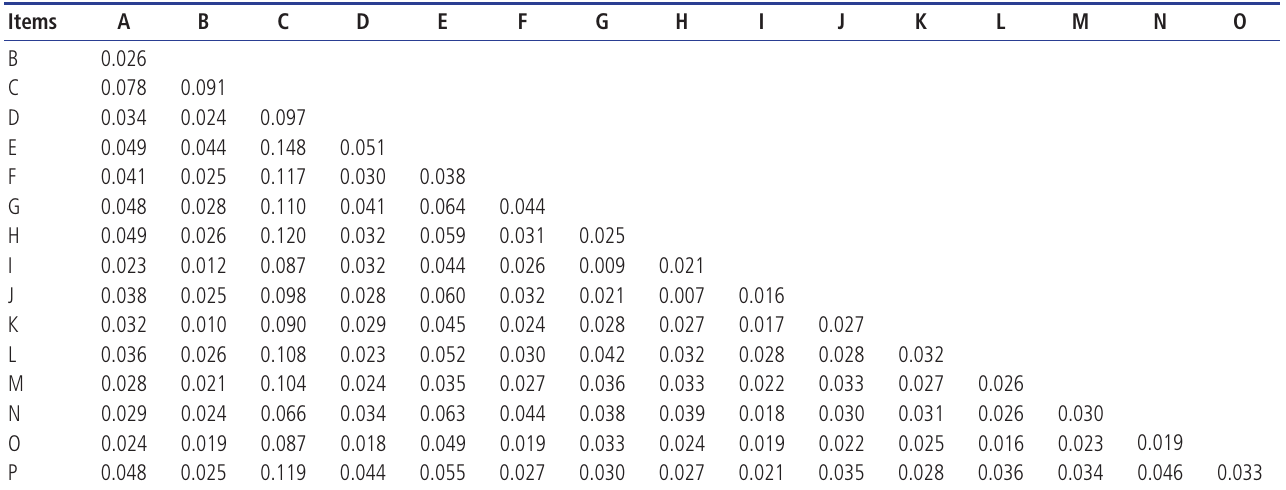
Table 3. Pairwise F values of the studied populations marked by letters ST